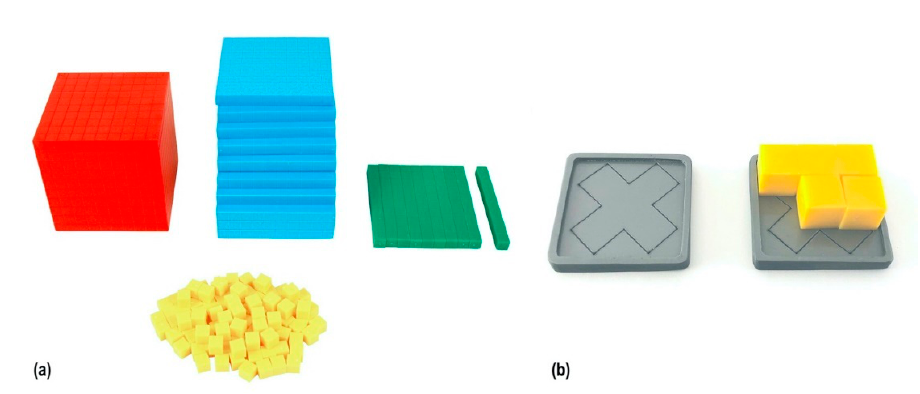
Figure 3. Physical objects used in X-is. ( a ) A base-10 block system, an existing and widely used manipulative, consisting of four different sizes and colours representing their individual place values: units (one’s place), rods (ten’s place), flats (hundred’s place), and cubes (thousand’s place). The system is familiar to teachers and students. Reprinted with permission [71] ; ( b ) X-Boxes (left) specially designed for X-is, which can be used with base-10 units when solving Level 1 equations (right).